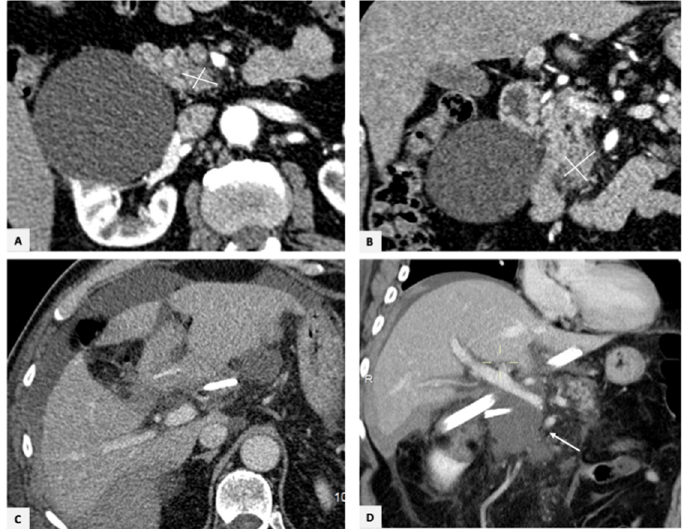
Figure 1. ( A , B ) Axial and coronal CT scan showing a pancreatic head adenocarcinoma. ( C , D ) Axial and coronal CT images in portal phase performed 2 days after re-look surgery showing peri-hepatic fluid collections (arrow) near the surgical drainages.